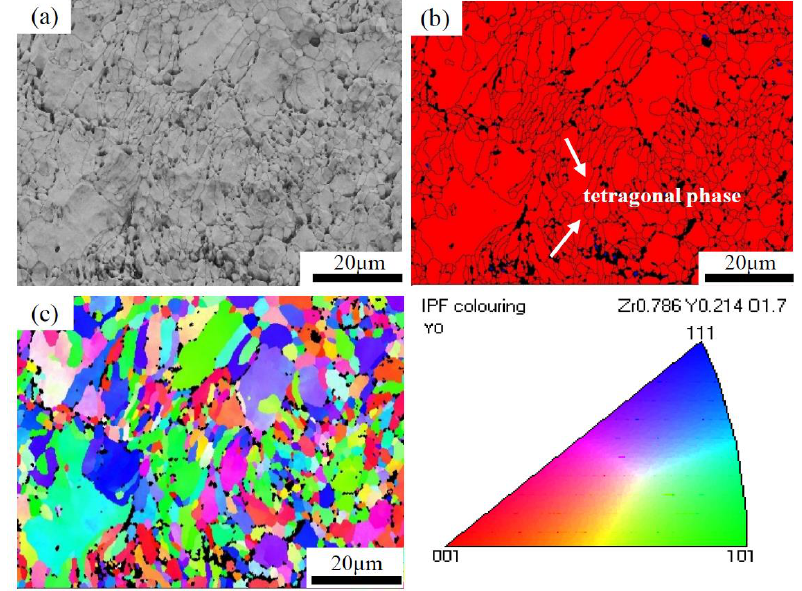
Figure 10. ( a ) SEM images, ( b ) EBSD phase maps of cross-sections of the top coating after 1600 °C/24 h thermal exposure and ( c ) orientation maps, Y-direction. (Tetragonal phase is meant as a group of t, t′ and t″ phases).